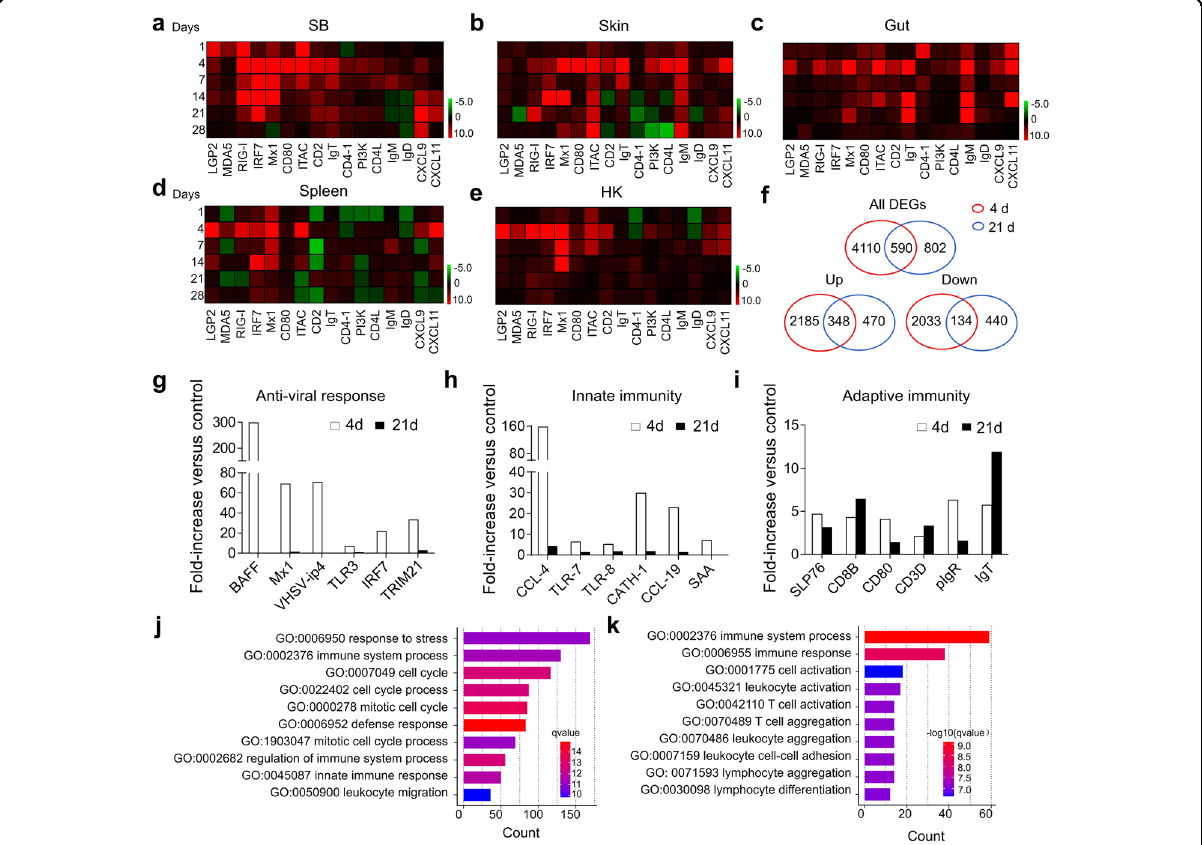
Fig. 3 Expression of immune genes and transcriptome analyses of trout SB mucosa upon IHNV infection. a – e Heatmaps illustrate results from quantitative real-time PCR of transcripts for selected immune markers from several lymphoid organs of IHNV-infected versus control fi sh measured at 1, 4, 7, 14, 21, and 28 DPI, SB ( a ), skin ( b ), gut ( c ), spleen ( d ), and HK ( e ) ( n = 9). Data are expressed as mean fold increase in expression. Color value: